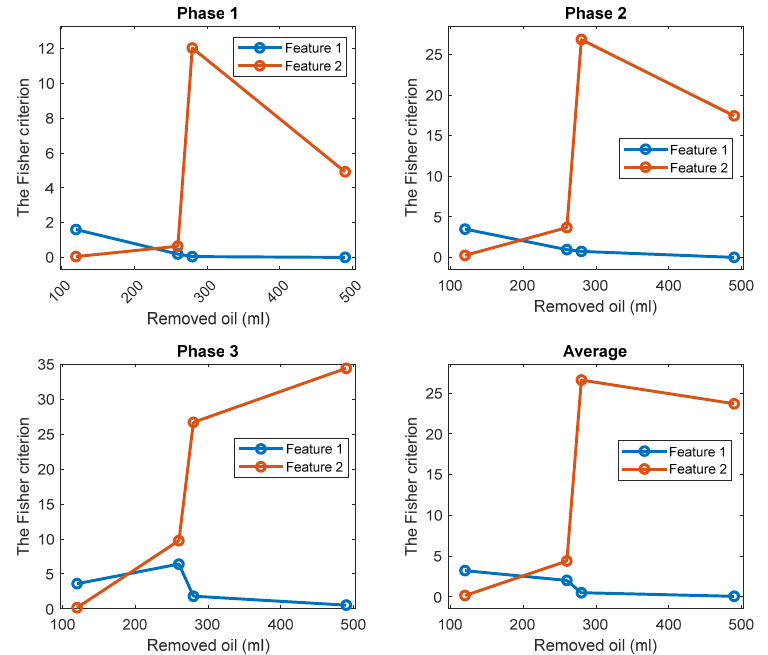
Figure 17. The FC for Feature 1 and Feature 2, respectively, for three phases and 4 levels of oil removal compared to the standard oil level (Day 2).